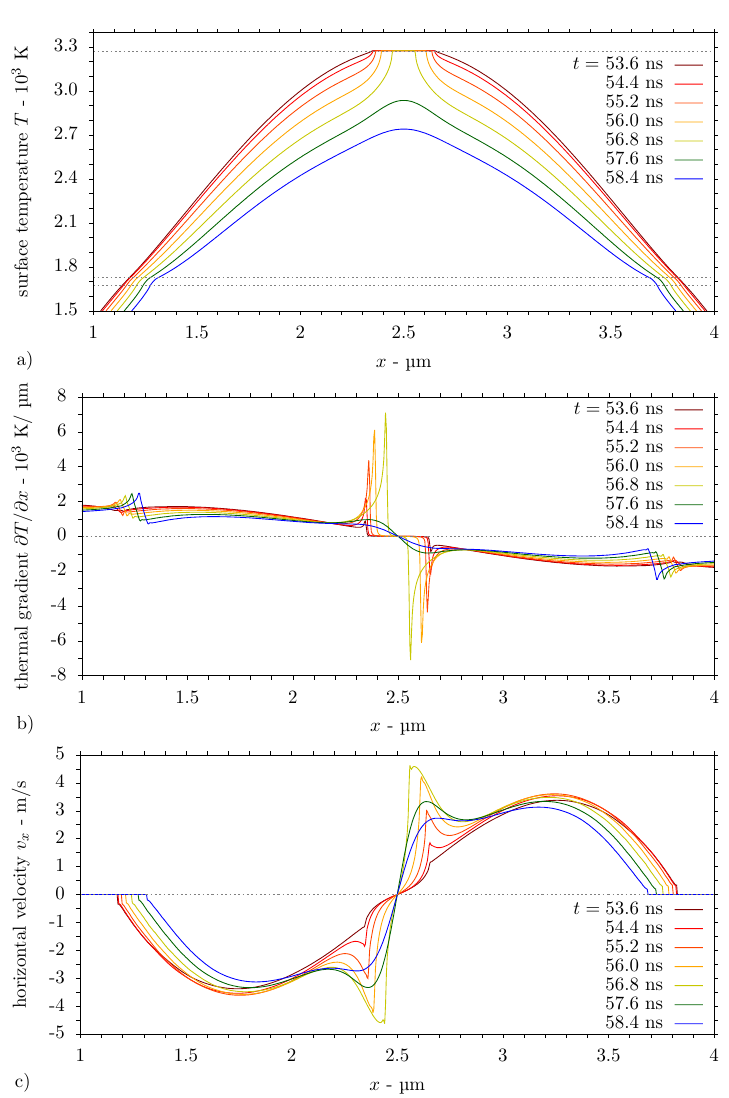
Figure 6. Evolution of ( a ) temperature, ( b ) horizontal temperature gradient, and ( c ) velocity at the melt pool surface during DLIP of AISI 304 stainless steel substrate for the laser fluence 2 Φ 0 = 0.5 J/cm 2